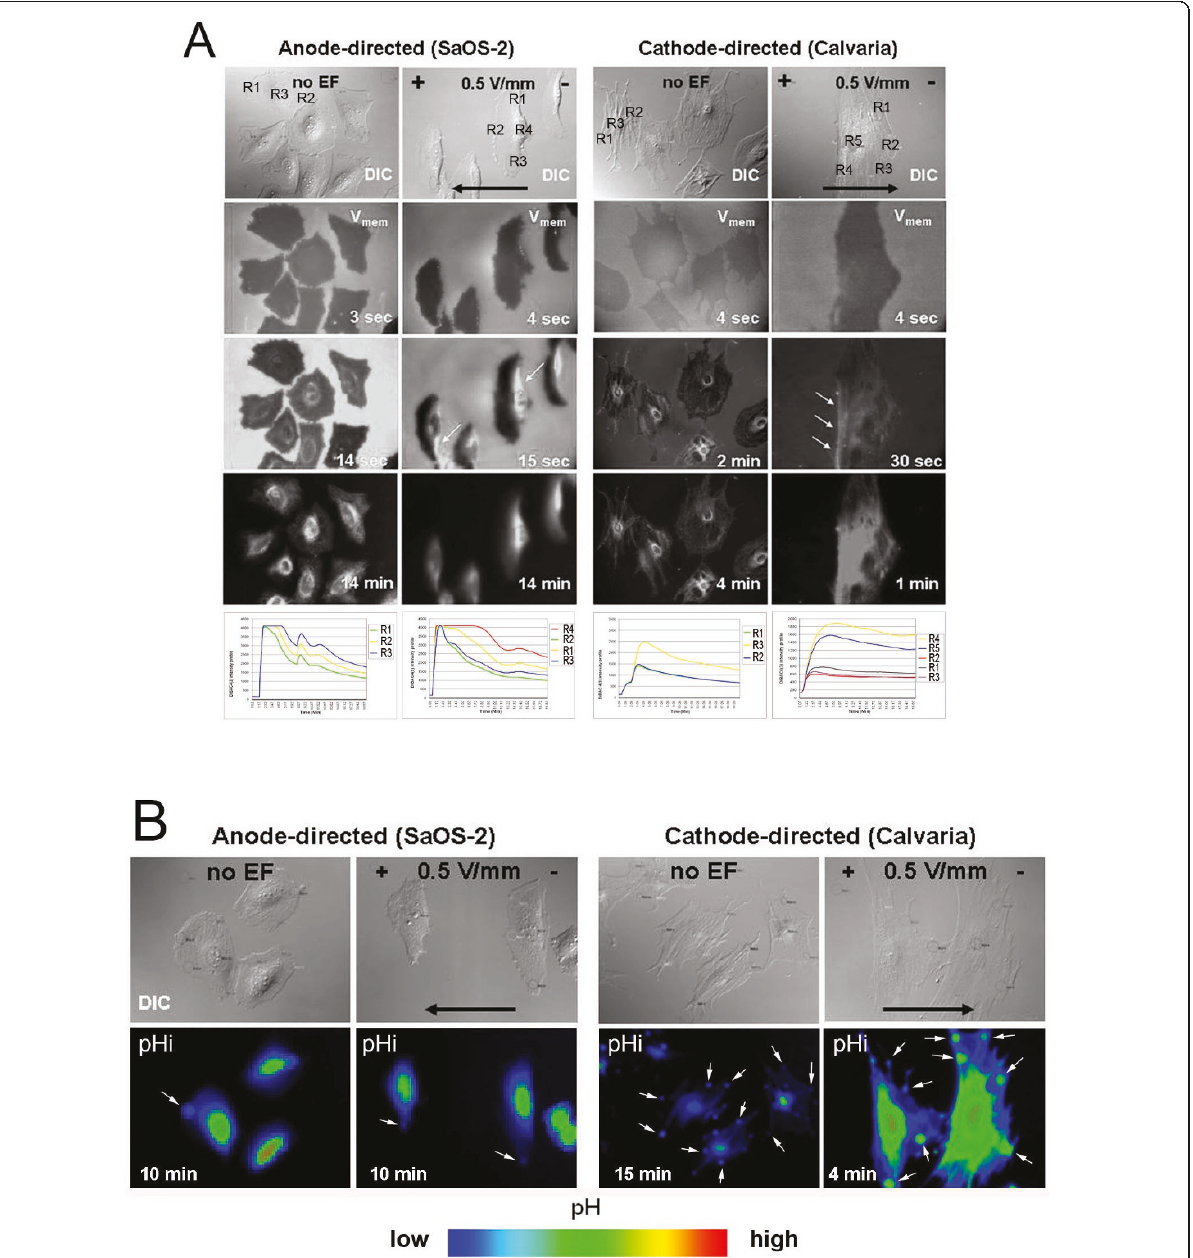
Figure 6 Spatiotemporal differences in V mem between the leading edge and the rear end in cathode (Calvaria)- or anode (SaOS-2)- directed cells . Fluorescence images showing the uptake of V mem reporter dye DiBAC 4 (3) at different time points after addition to the cells. White arrows in the second row point to the depolarized cell membrane, wherein the anionic dye first enters from sites that have a decreased number of negative charges (depolarized) at the rear end in both anode (left)- and cathode (right)-directed cells (A). pH bubbles (white arrows), especially recognizable in cathode-directed cells (right column), can be observed at the termini of membrane protrusions along the cell periphery in randomly migrating, nonpolarized cells and at the leading-edge of directed, polarized cells. False colored (LUT) images generated from ratiometric images showing cells loaded with BCECF-AM, a pH reporter, ratiometric dye (B). In both (A) and (B), the first row shows DIC images of the cells during random (no EF) and directed (0.5 V/mm) migration. Black arrows in the DIC images indicate the direction of